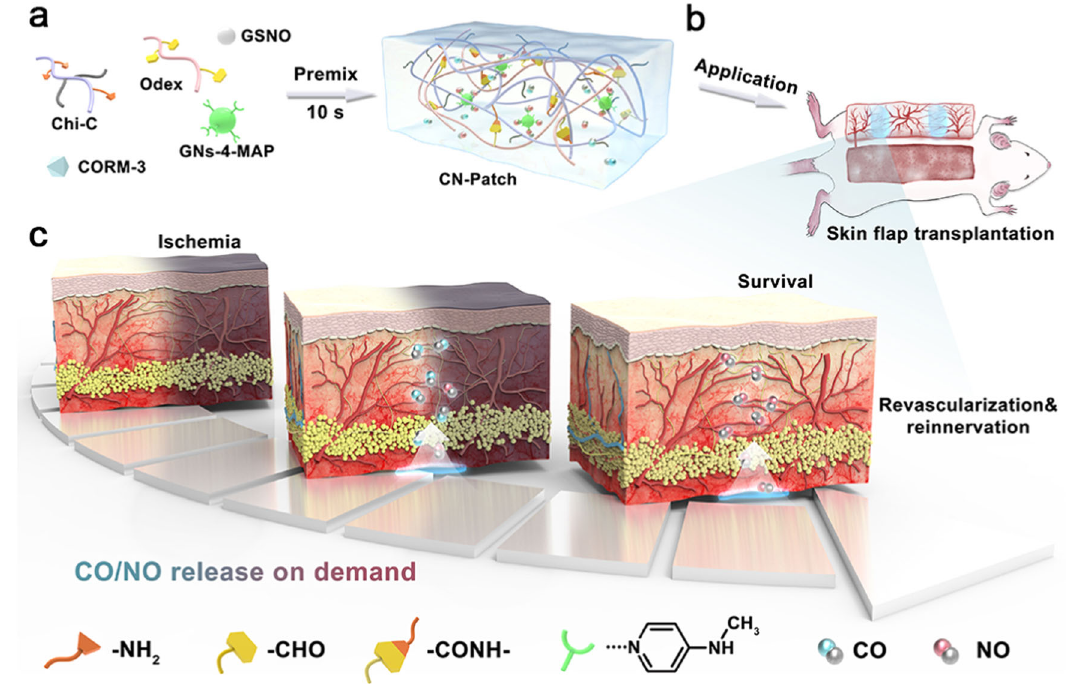
Fig.1|SchematicrepresentationforthedesignstrategyandapplicationofCN- Patchhydrogelforrevascularizationofskingraft.a Theschematicofthedesign strategy of the CN-Patch hydrogel. b The surgery fl ow chart of single pedicle